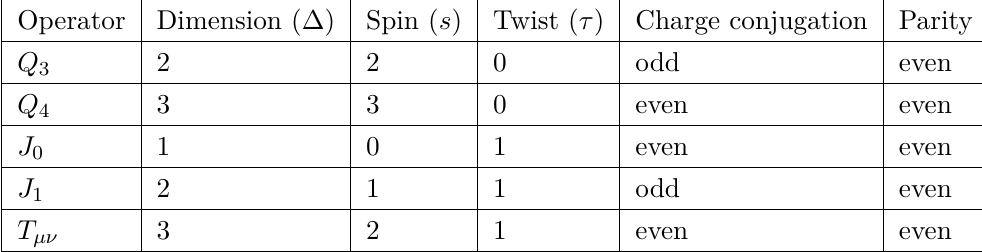
Table 1 . Data of charges and operators of interest in the bosonic